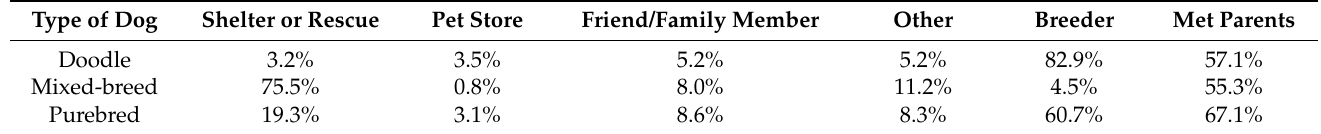
Table 2. Sources of each type of dog, including the percentage of people who bought their dog from a breeder and met the